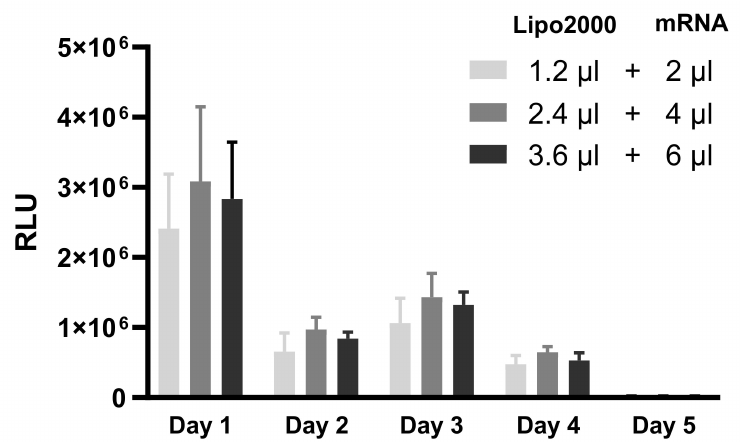
Figure 2. Time course of luciferase secretion after transfection with IVT-mRNA lipoplexes. Complexes were prepared by mixing 1.2 µ L, 2.4 µ L or 3.6 µ L Lipofectamine2000 with 2 µ L, 4 µ L or 6 µ L MetLuc- mRNA in OptiMEM. “Lipo2000” represents Lipofectamine2000 and “mRNA” represents MetLuc- mRNA. 16HBE cells were incubated with the complexes for 2 h. The luciferase activity was measured every 24 h till the relative light units measured with a luminometer dropped below 500 (background level). After each measurement, the medium was removed and the cells were supplied with fresh cell culture medium. The results are presented as relative light units (RLU), n =